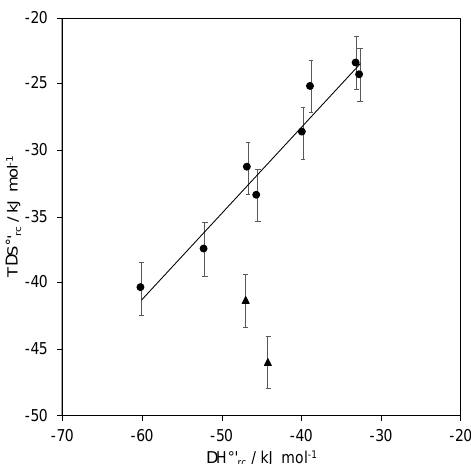
Figure 6. Enthalpy–entropy compensation plots for the reduction thermodynamics of Streptomyces coelicolor small laccase (SLAC) electrostatically and covalently immobilized on a gold electrode coated with MUA, 3:1 MUA/MU, 1:1 MUA/MU, 1:2 MUA/MU, MUA(EDC/NHS), 1:1 MUA/MU(EDC/NHS) at pH 7.0 ( ● ), and covalently immobilized with 1:1 MUA/MU(EDC/NHS) at pH 8.4 and 9.6 ( ▲ ). T=293 K. Error bars are reported when available or have the same dimensions of symbols. The reduction thermodynamics at pH 7, compared with those for other T1 centers in laccase s and cupredoxins indicate that the positive E°’ value for these centers invariably have an enthalpic origin as both enthalpic and entropic terms are negative, although the latter term may be significant, as for SLAC (Table 2). The nature of the adsorbing surface certainly affects E°’ , but the compensative nature of the two thermodynamic terms is con- served. The E°’ value of SLAC immobilized on MUA/MU is low compared to other copper proteins because of remarkable negative S°’ values. Indeed, the H°’ values are compa- rable with those of other Type 1 Cu centers with much more positive potentials. The pH dependence of E°’ for SLAC covalently bound to 1:1 MUA/MU -functional- ized gold electrode through the EDC/NHS linkage procedure is shown in Figure 7. The reduction thermodynamics at the selected pH values of 7.0, 8.4, and 9.6 are listed in Table 1. The E°’ vs. pH plot exhibits two linear regions, the former between pH 5.7 and 7.9 and the latter starting at about pH 9, with a slope of 58 and 85 mV per pH unit, respectively, corresponding to the loss of about one and two protons with small pK a differences. The pH profile and the overall E°’ change at the two extremes of pH is consistent with that which was observed previously for the same species immobilized on pyrene- and neocu- proine-modified graphite disc electrodes [44]. The data were fitted to a three-equilibria equation involving one and two reduction induced proton uptake at low and high pH, respectively: 𝐸° ′ = 𝐸° ′ 𝑙𝑜𝑤 𝑝𝐻 + 0.059 ∙ 𝑙𝑜𝑔[(𝐾 𝑎1𝑂𝑥 + [𝐻 + ]) (𝐾 𝑎1𝑅𝑒𝑑 + [𝐻 + ])⁄ ] + +0.059 ∙ 𝑙𝑜𝑔[(𝐾 𝑎2𝑂𝑥 + [𝐻 + ]) (𝐾 𝑎2𝑅𝑒𝑑 + [𝐻 + ])⁄ ] + +0.059 ∙ 𝑙𝑜𝑔[(𝐾 𝑎3𝑂𝑥 + [𝐻 + ]) (𝐾 𝑎3𝑅𝑒𝑑 + [𝐻 + ])⁄ ]